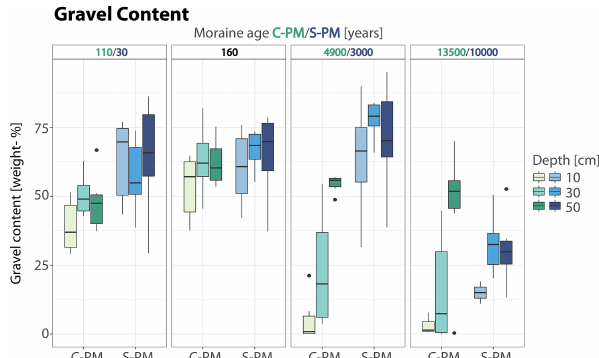
Figure 5. Development of gravel at 10, 30, and 50cm over 10 mil- lennia on silicate (S-PM, shown in blue color scale) and calcareous (C-PM, shown in green color scale) parent